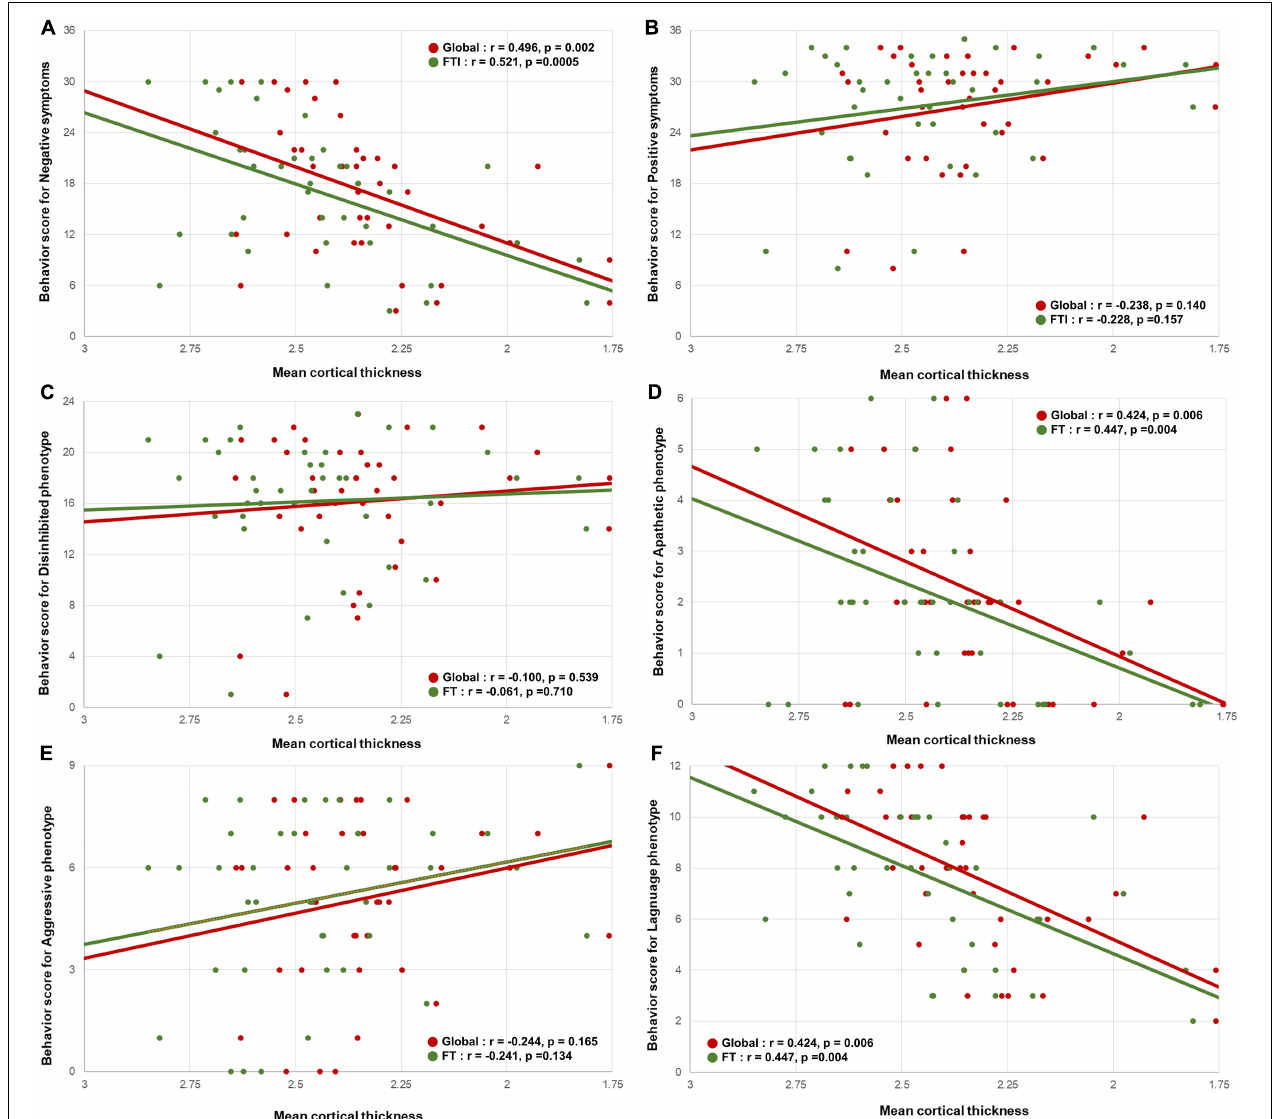
FIGURE 2 | Correlation between the mean cortical thickness and the behavioral scores. Scatterplots showing the relationship between the behavioral scores for negative symptoms and the behavioral variant frontotemporal dementia neuropathology imaging biomarkers. (A) The behavioral scores for negative symptoms were positively correlated with the global mean cortical thickness and fronto-temporo-insular mean cortical thickness. (B) The behavioral scores for positive symptoms were not correlated with the global mean cortical thickness and fronto-temporo-insular mean cortical thickness. In phenotype aspects. (D,F) The behavioral scores for apathetic and language phenotypes were positively correlated with the global mean cortical thickness and fronto-temporo-insular mean cortical thickness. (C,E) The behavioral scores for disinhibited and aggressive phenotype were not correlated with the global mean cortical thickness and fronto-temporo-insular mean cortical